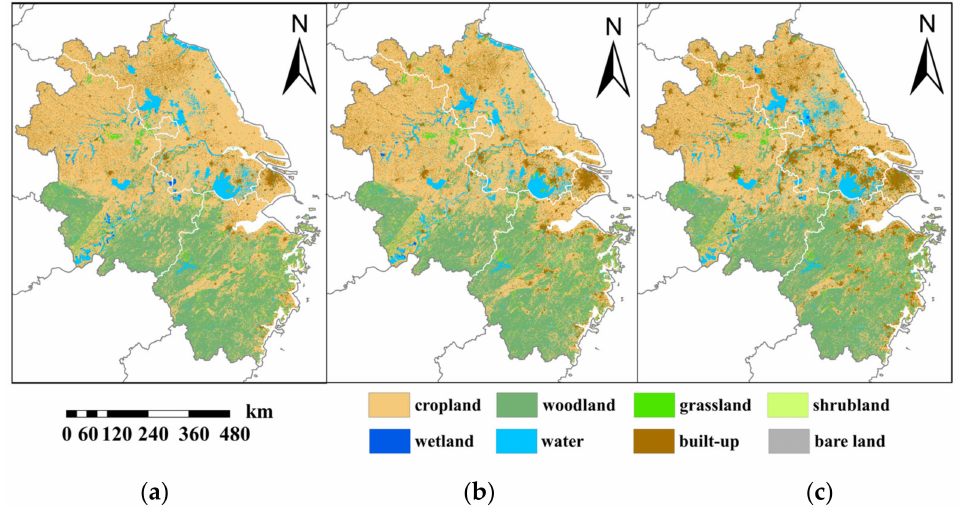
Figure 5. Land use patterns: ( a ) land use pattern of 2000, ( b ) land use pattern of 2010, ( c ) land use pattern of